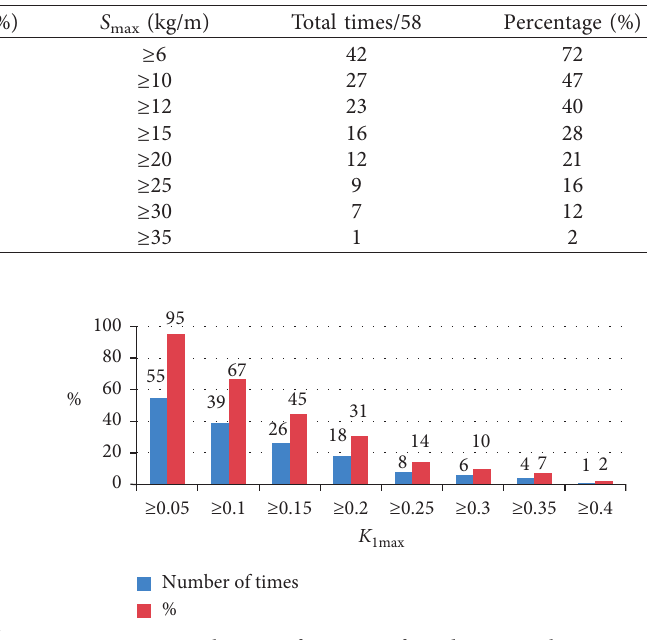
Figure 27: Distribution of 58 sets of prediction cycle cuttings desorption index K 1max